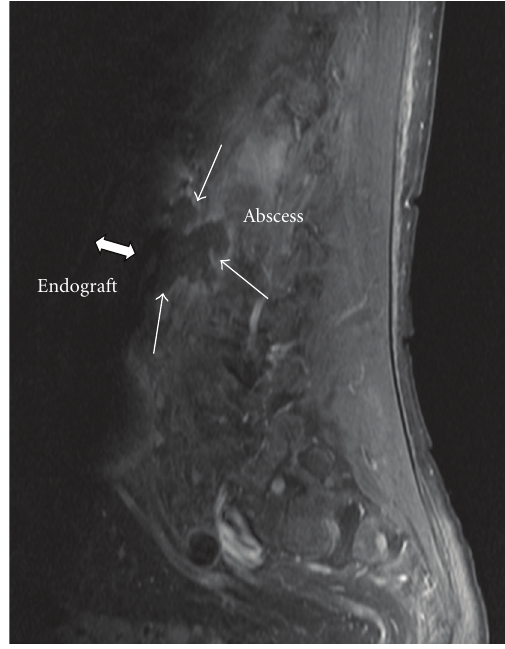
Figure 1: Sagital view of preoperative MRI-scan showing a retroaortal fluid collection with slight enhancement reaching to the dorsal part of the prosthetic